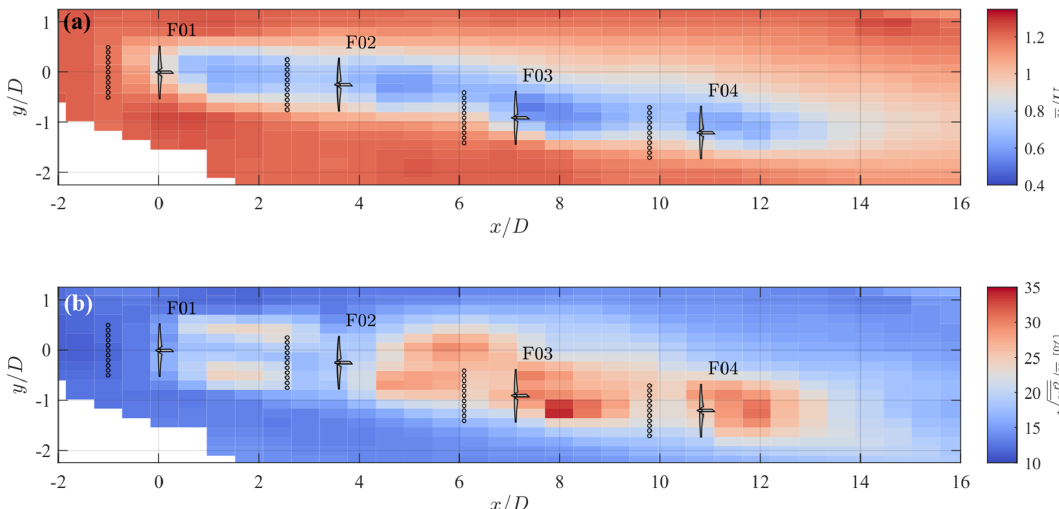
Figure 17. Velocity statistics of the wakes generated by turbines F01–F04 reconstructed over the horizontal plane at hub height. (a) Mean streamwise velocity and (b) streamwise turbulence intensity. The black dots indicate the sampling locations used for the estimation of the incoming flow for the respective turbine.